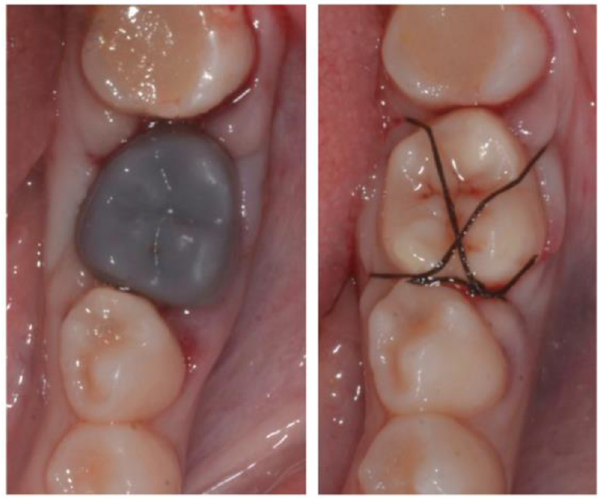
Fig. 5. Inspection of alveolar adaptation to the surgical template before transplantation, followed by the placement of the transplant.